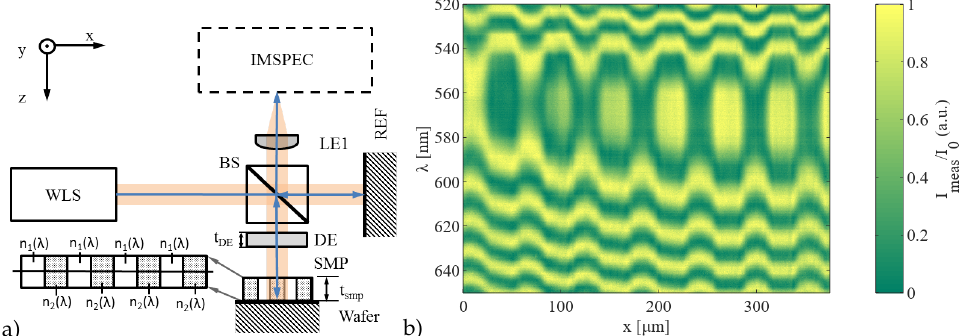
Figure 1. ( a ) Schematic of the measurement setup with WLS—white-light source, BS—beam splitter, REF—fixed reference mirrors, DE—additional dispersive element with thickness t DE and spatially uniform refractive index n DE , SMP—sample on a wafer with the thickness t smp and cross section with spatially varying refractive indices n 1 ( λ ) and n 2 ( λ ) , LE1—lens to image the sample on the spectrometer, IMSPEC—imaging spectrometer, where beam paths are marked with blue arrows. ( b ) Example spatial data with the refractive index encoded in the modulation of the measured spectral intensity I meas with respect to the spectral intensity of the light source I 0 ( y - and z -axis) of a polymer sample with lines and spaces of differently cross-linked sections having a pitch width of 50 µ m along a line in the